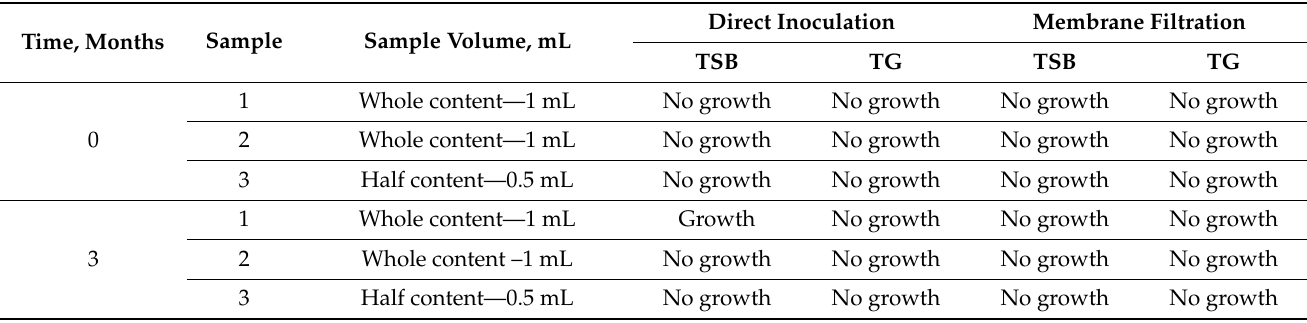
Table 4. Microbiological purity test results for eye drops with CS (2%) and HA (0.4%) stored in immediate packaging (minims) under controlled conditions (40 ◦ C/75%